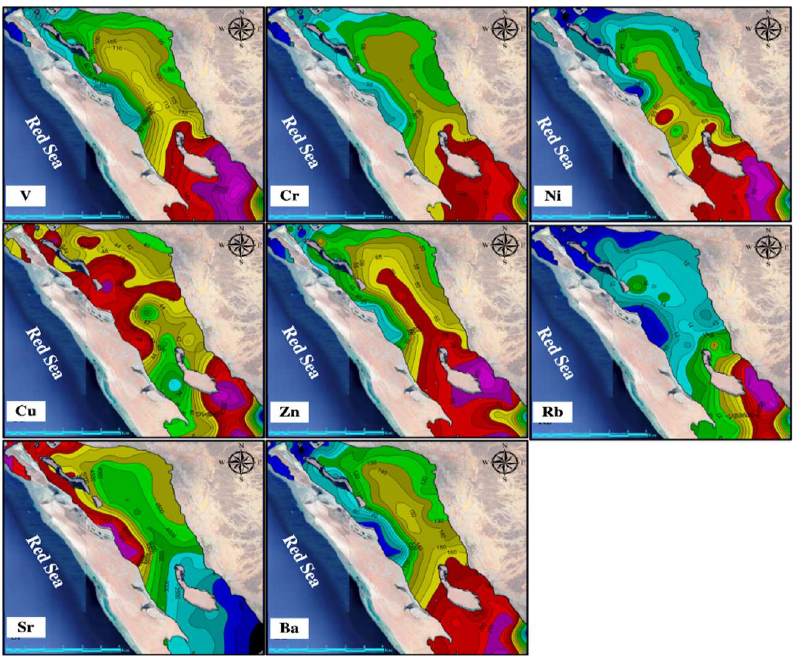
Figure 4. Contour maps showing the spatial distribution of the concentrations of trace elements (µg/g) in the bottom sediments of the Sharm Al-Kharrar. Light blue scale bar on maps equals 6 km